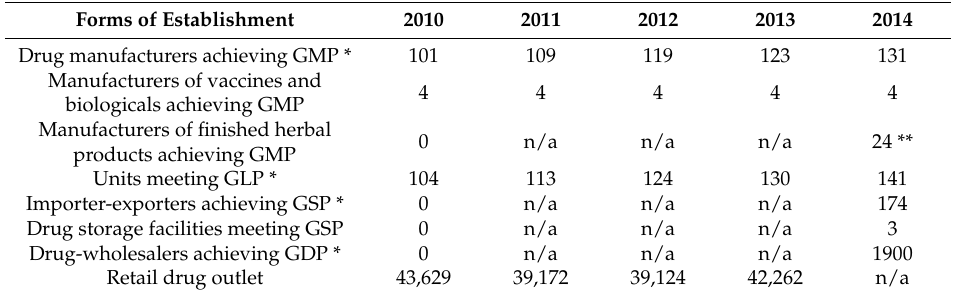
Table 1. Number of pharmaceutical establishments by type, 2010–2014.